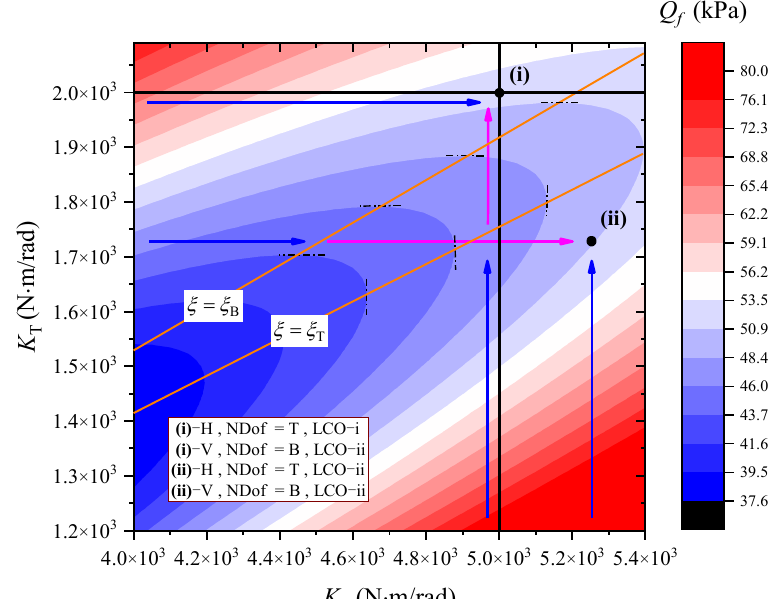
Figure 6. Linear flutter dynamic pressure with the variation of bending and torsional stiffnesses. The LCO characteristics of the all-movable fin with bending or torsion freeplay nonlinearity in linear states (i) and (ii) are shown,